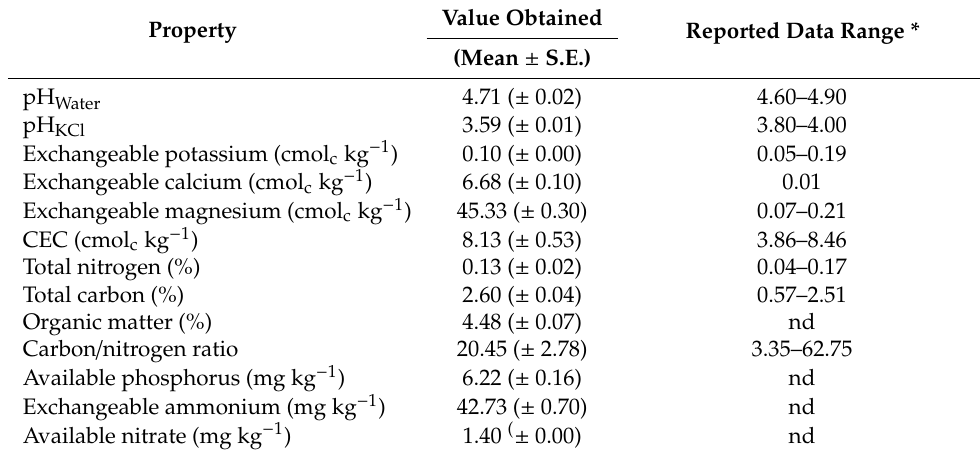
Table A1. Selected chemical properties of Bekenu